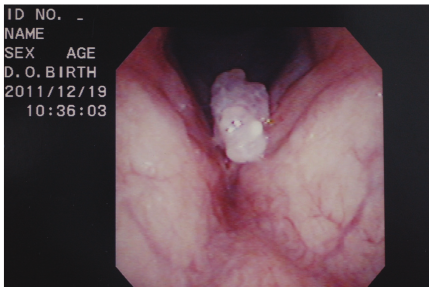
Figure 1: A mass of surface irregularity in the anterior one-third part of the left vocal cord.